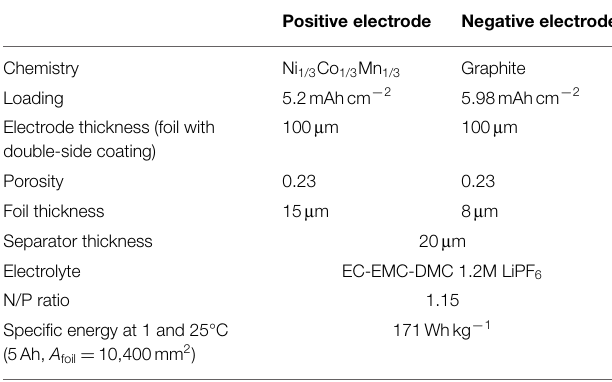
TABLE 2 | Cell internal structure and design parameters for alternative energy cell used for some simulations in Section “Cell Capacity with Fixed